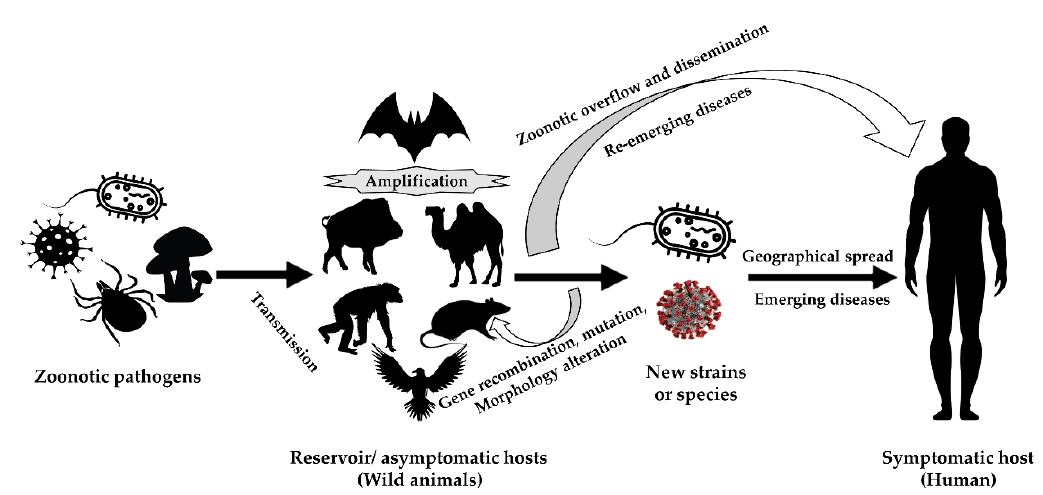
Figure 1. The involvement of the wild animals in the transmission and amplification of etiological agents of emerging and re-emerging zoonoses (modified with permission from